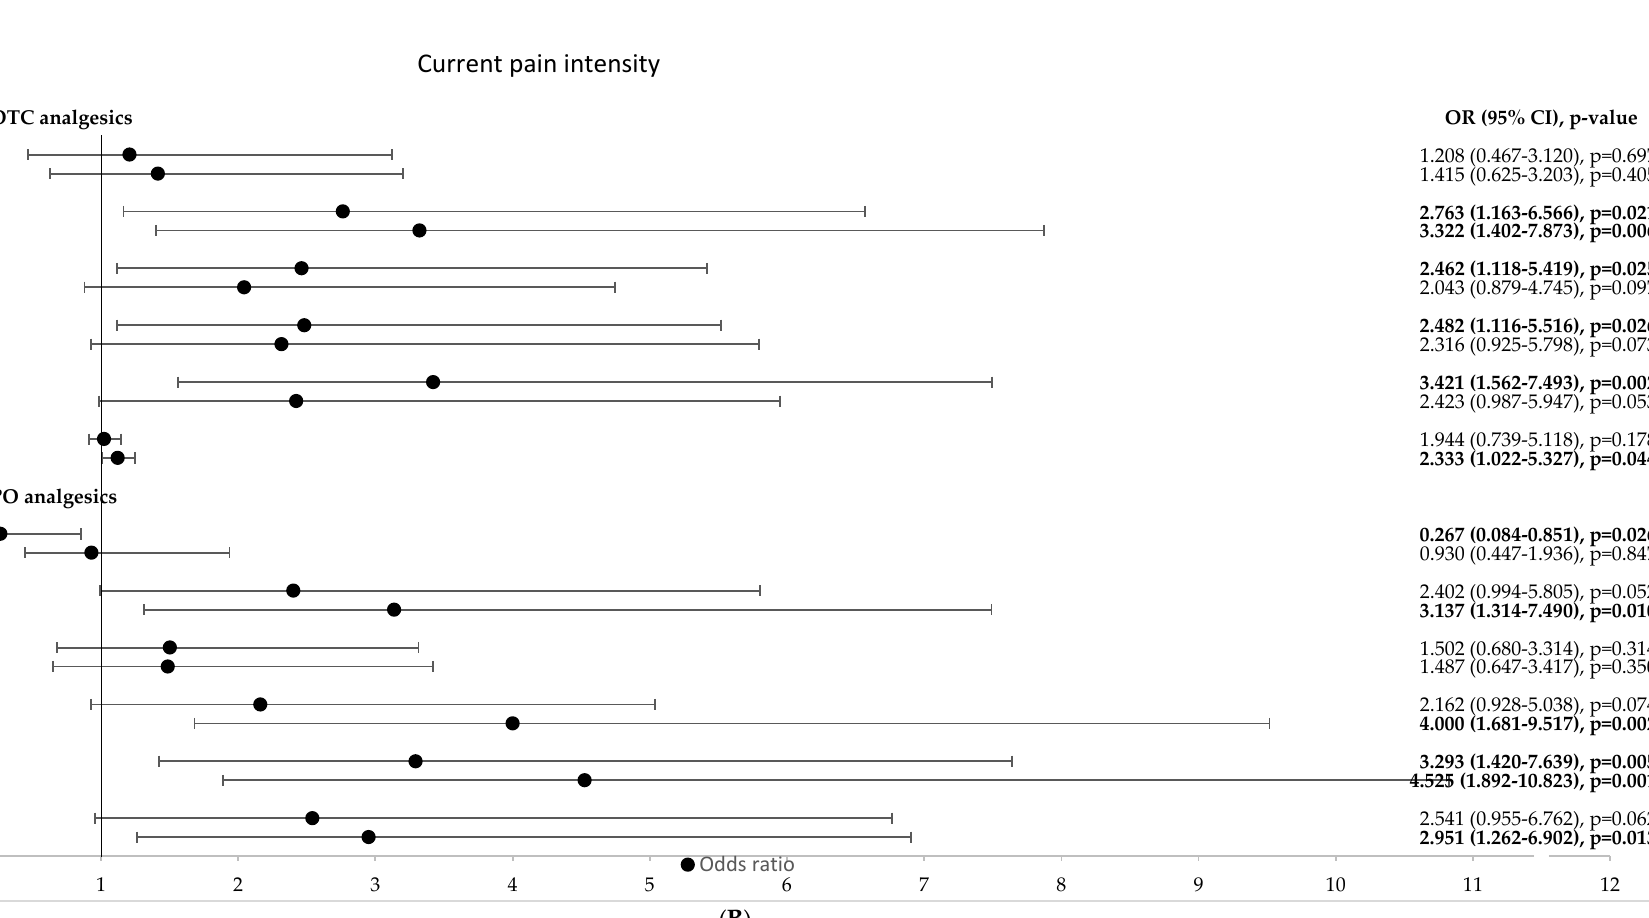
Figure 2. Influence of pain level on increased intake of OTC and PO analgesics (univariate logistic regression analysis). ( A ). Pain level previous to the COVID-19 pandemic. ( B ). Current pain level. OR = odds ratio; CI = confidence interval; m = medium pain intensity; h = high pain intensity. Values in bold indicate statistical significance; the level of statistical significance was set to p < 0.05.